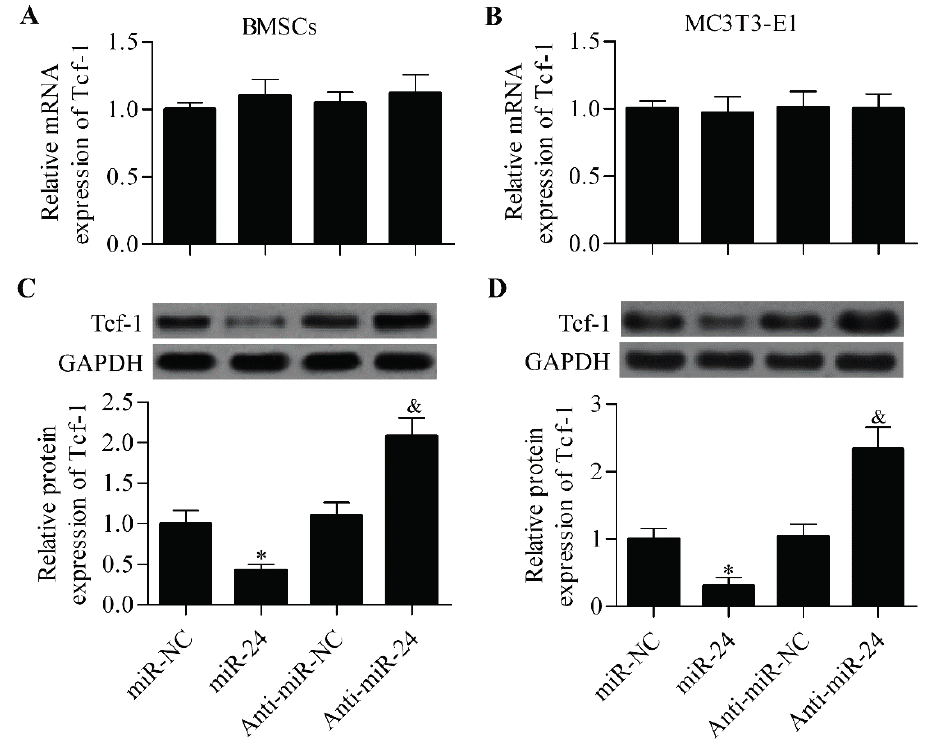
Figure 5. miR-24 regulates Tcf-1 expression in BMSCs and MC3T3-E1 cells. RT-qPCR analysis of Tcf-1 mRNA expression in BMSCs ( A ) and MC3T3-E1 cells ( B ) transfected with miR-24 or anti-miR-24; Western blot analysis of Tcf-1 protein expression in MSCs ( C ) and MC3T3-E1 cells ( D ). Relative protein expression level was quantified using Image-Pro Plus 6.0 software (Media Cybernetics, Inc., Rockville, MD, USA). Cells transfected with miRNAs for 48 h before harvested for analysis. N = 3, * p < 0.05 vs. miR-NC; and & p < 0.05 vs.